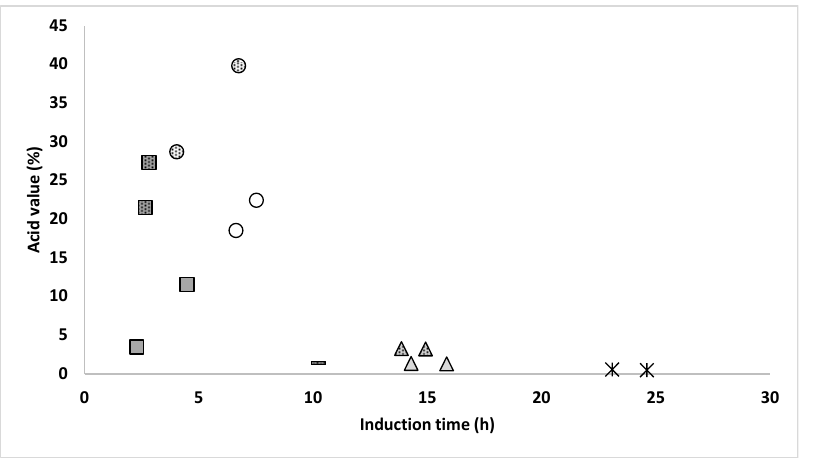
Figure 3. Correlation between induction time after Rancimat test (h) and acid value (%) of the fat from BSFL processed by different methods of slaughtering, drying, and defatting. Undotted circles (freezing, freeze-drying, mechanical pressing), dotted circles (freezing, freeze-drying, SFE), undot- ted triangles (freezing, oven-drying, mechanical pressing), dotted triangles (freezing, oven-drying, SFE), undotted squares (blanching, freeze-drying, mechanical pressing), dotted squares (blanching, freeze-drying, SFE), asterisks (blanching, oven-drying, mechanical pressing), line (blanching, oven- drying, SFE).